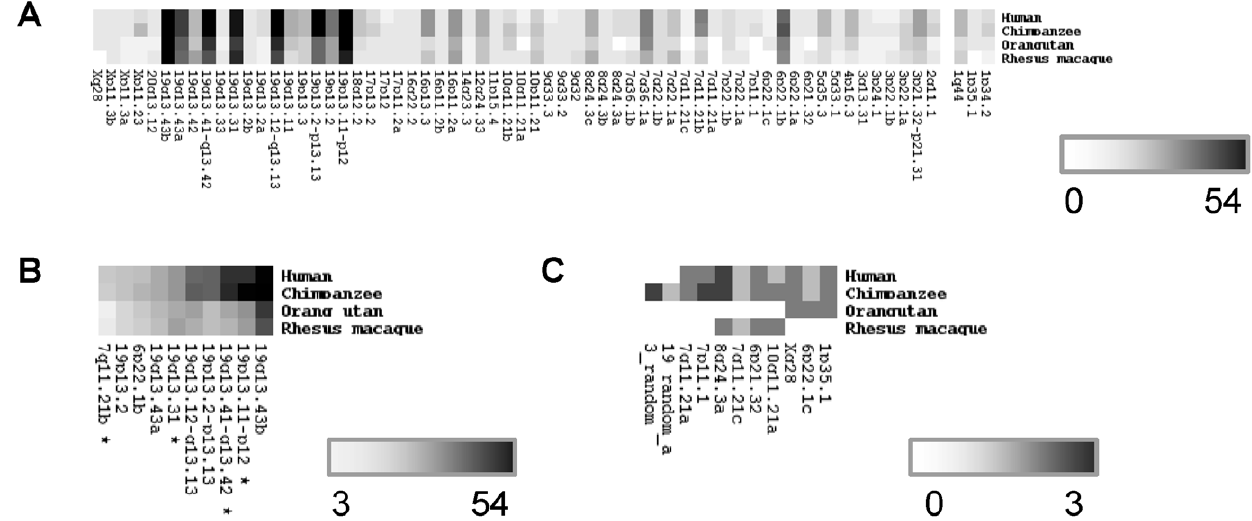
Figure 1. Number of KZNF genes per cluster for the four investigated primates. The legend indicates the number of genes – the darker the fields the more genes are in the cluster. A: All clusters. B: The ten largest clusters. C: Lineage-specific clusters. The asterisk indicates clusters that had orthologs located on random or unknown chromosomes. doi:10.1371/journal.pone.0021553.g001 PLoS ONE |